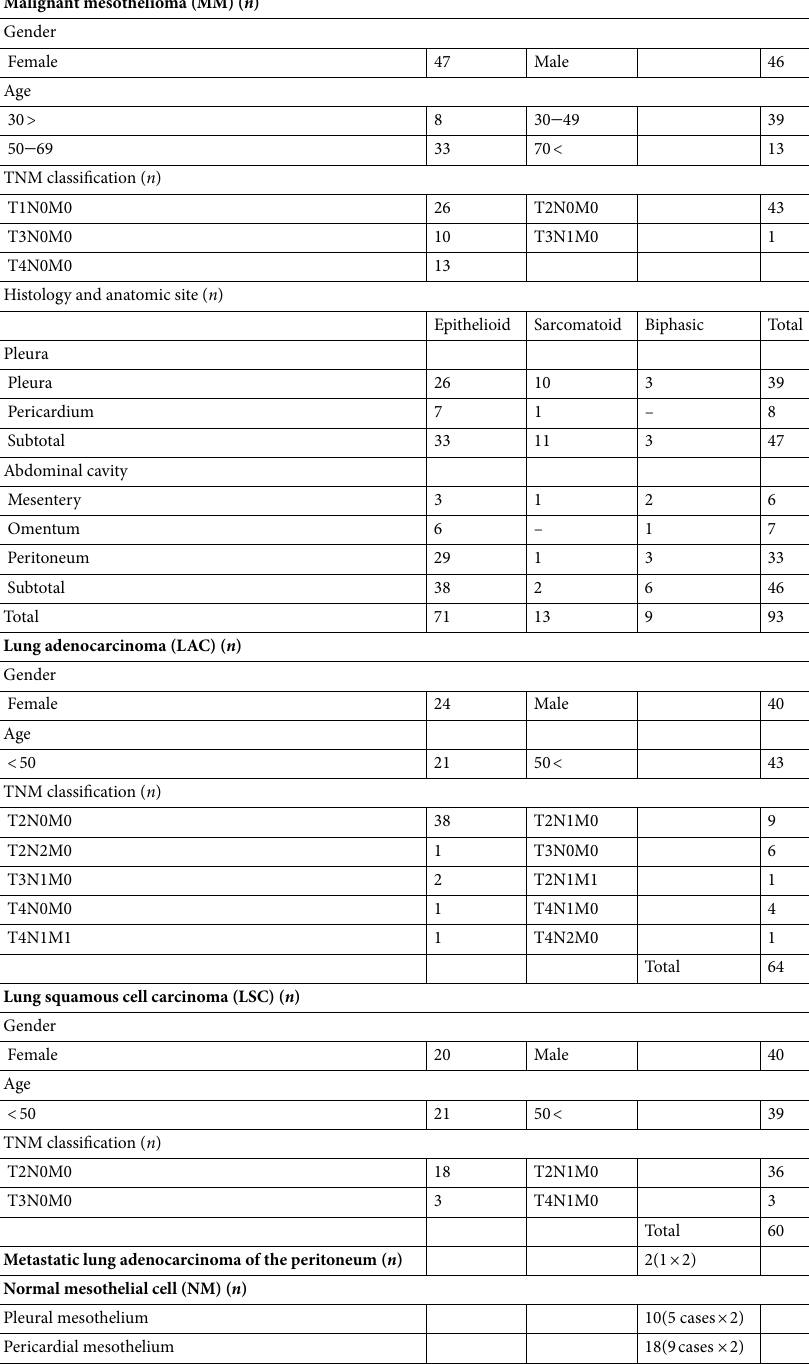
Table 1. Patient characteristics. Number of patients denoted by